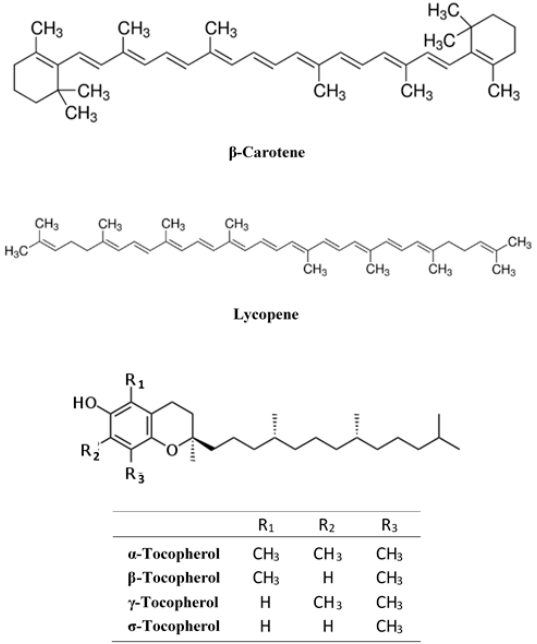
Figure 2. Chemical formulas of lipid-soluble antioxidants of rose hips.